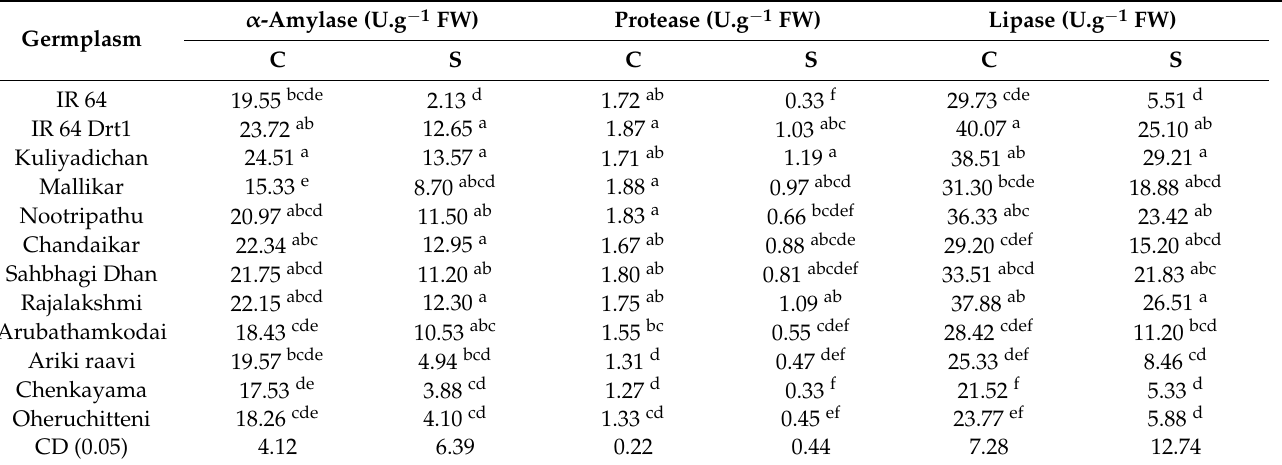
Table 2. Influence of moisture stress on hydrolytic enzyme activities in the germinated seeds in selected rice